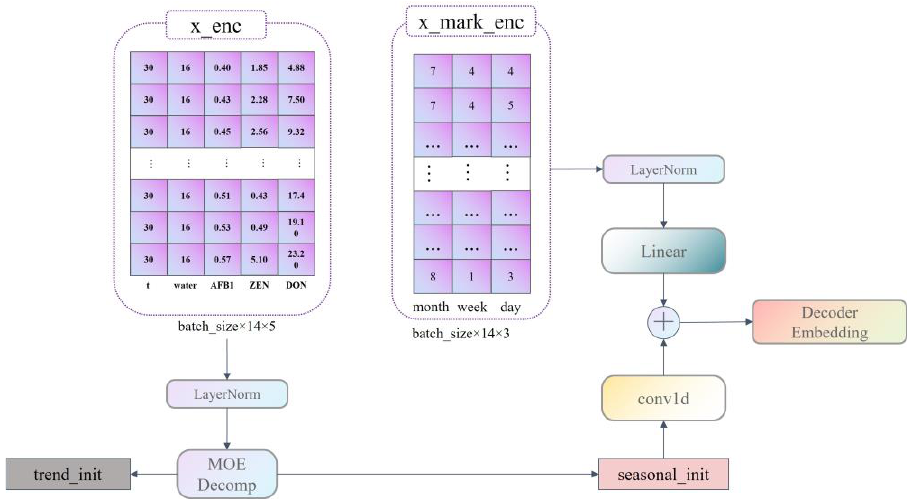
Figure 3. Decoder Embedding Construction Flowchart.